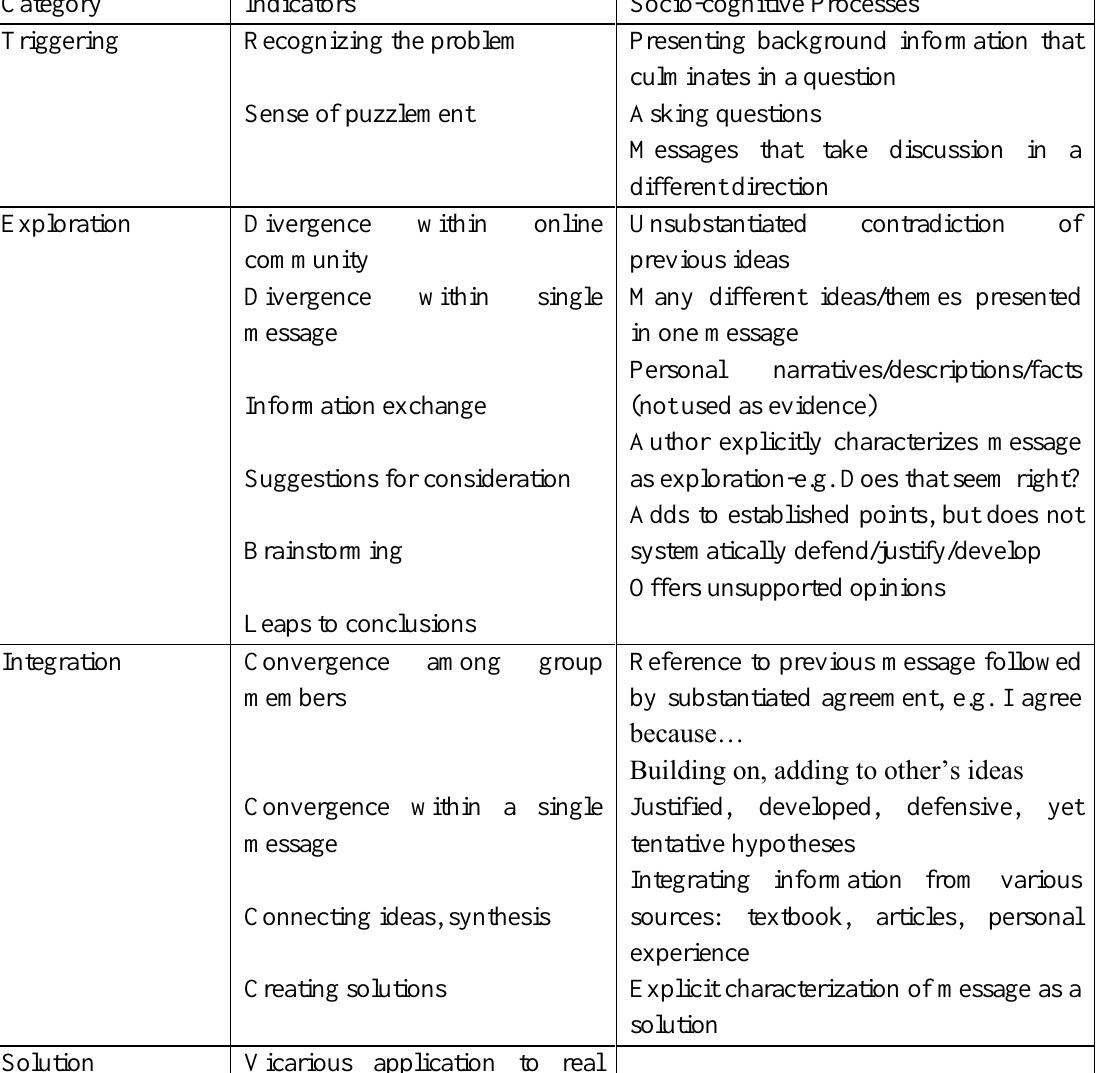
Categories of Contributions (Based on Garrison et